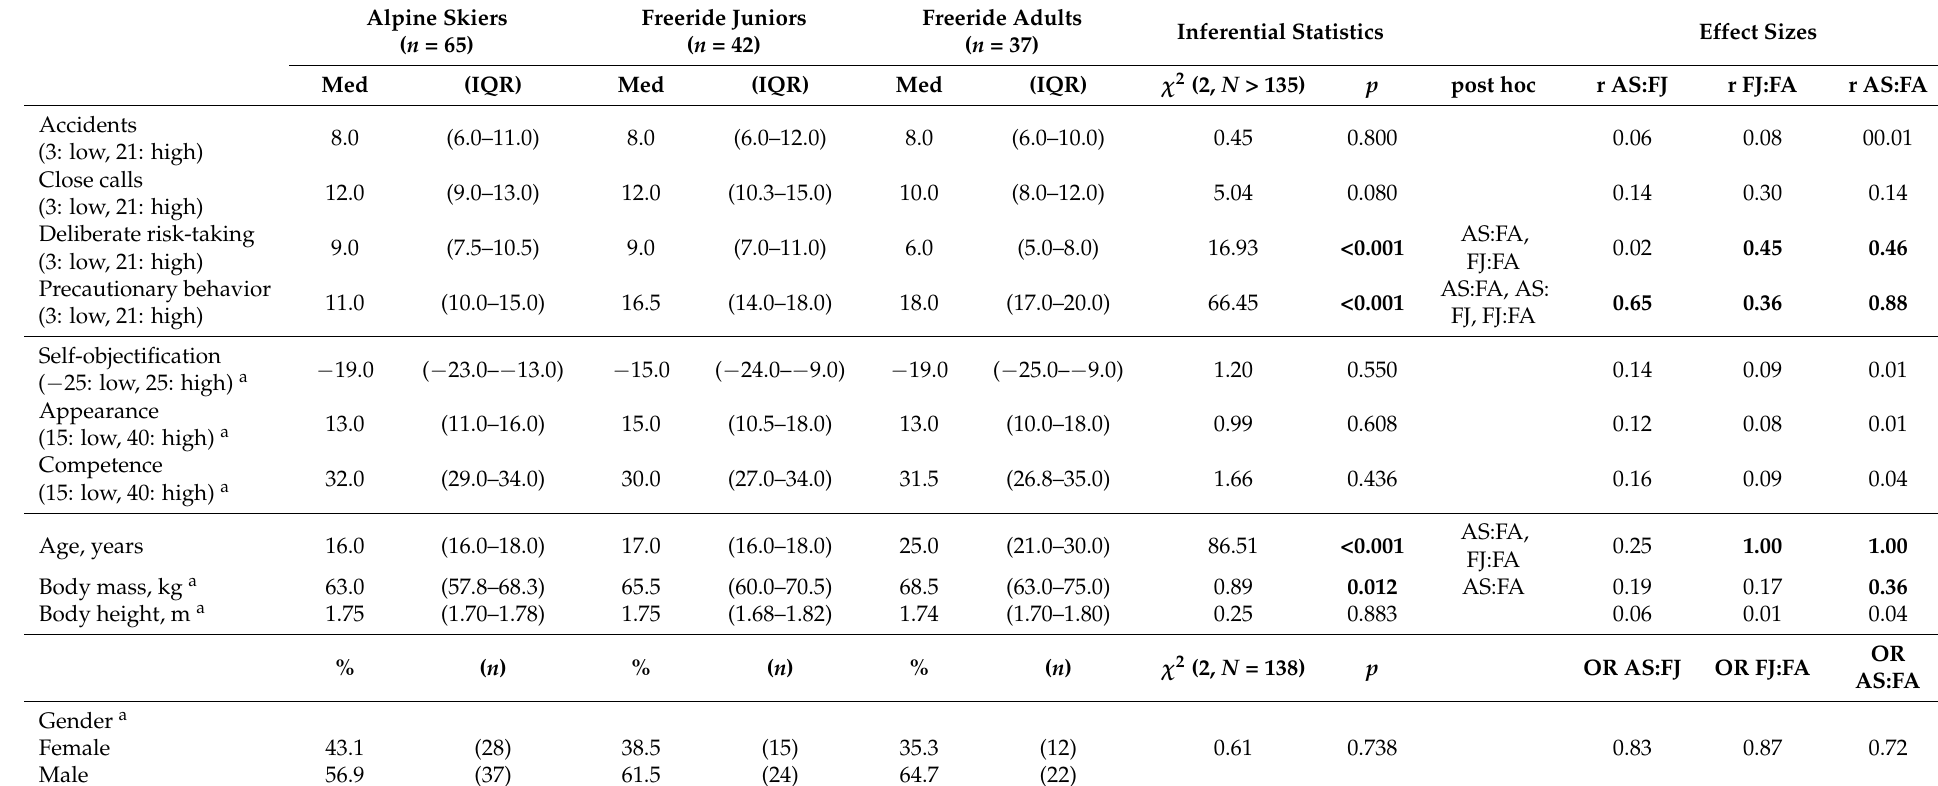
Table 1. Data on risk-related variables, self-objectification and demographic aspects by